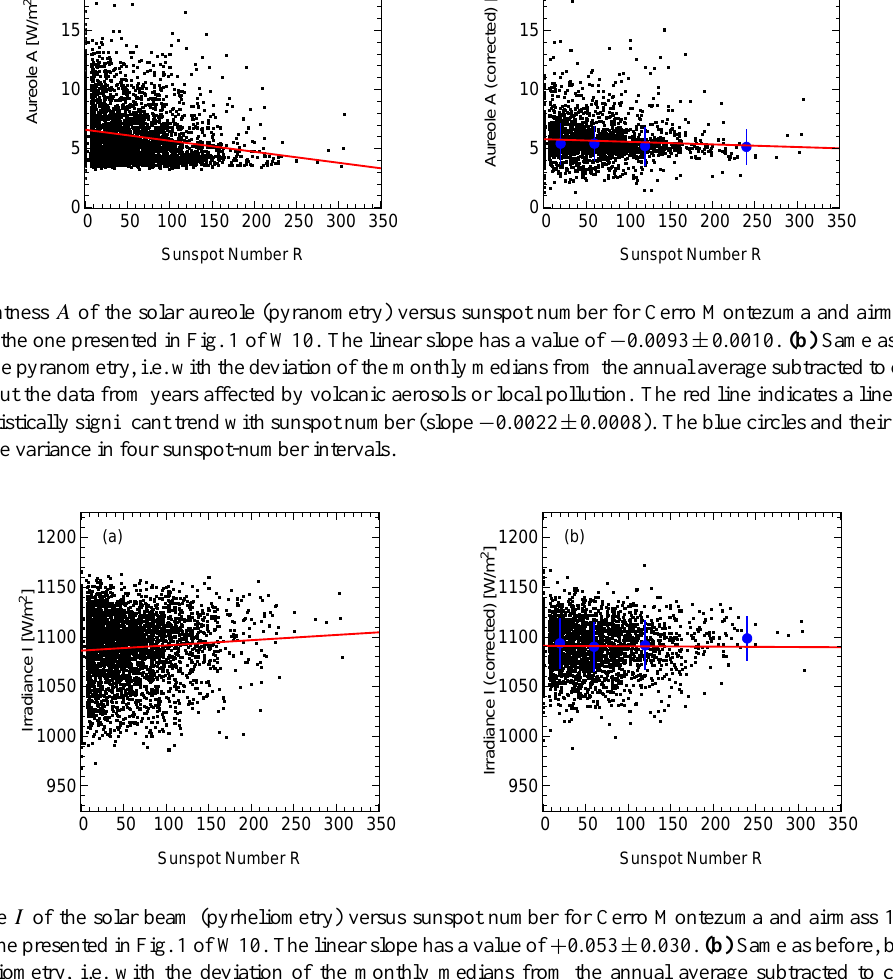
Table 1 corresponds to a variation of 0.13% between R = 0 and R = 150, which is the order of magnitude for the varia- tion of the total solar irradiance at the top of the atmosphere derived from satellite measurements between solar maxima and minima (e.g. Fr¨ohlich and Lean,